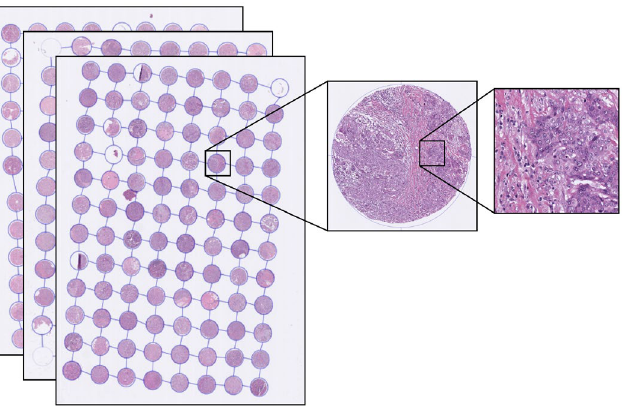
Figure 1. Magnified view of a tissue patch (right) extracted from one core (middle) of a TMA (left) from the TNBC cohort. On average each core is 1.25 mm in diameter. All slides were scanned at 0.25 µm/pixel resolution.